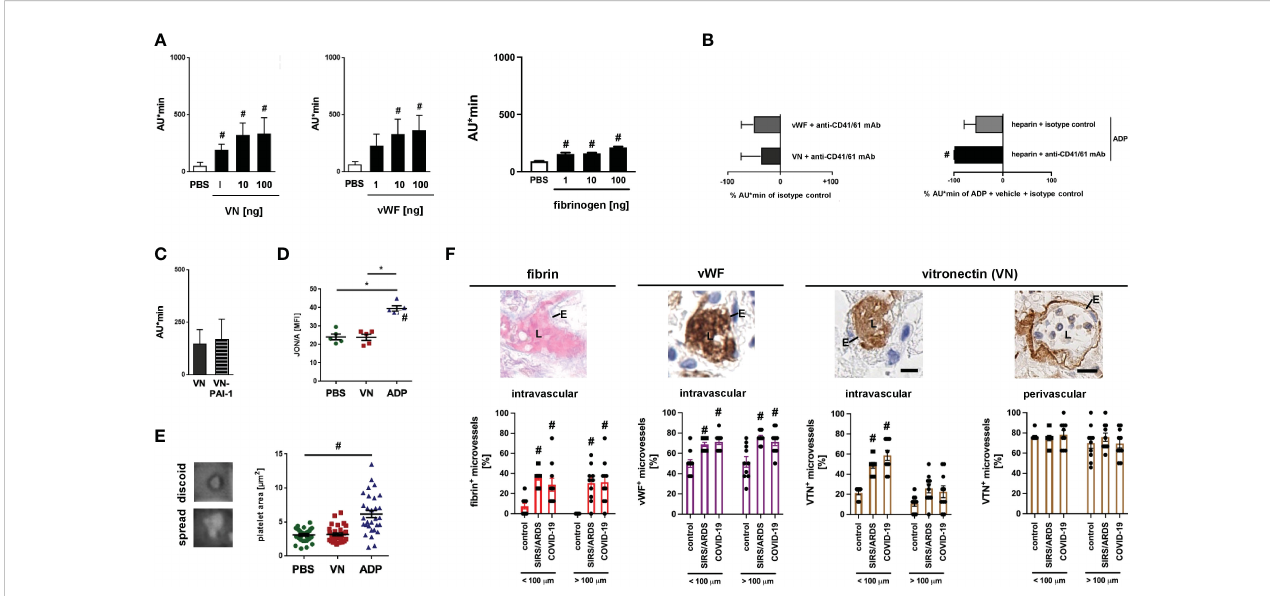
FIGURE 4 VN promotes platelet aggregation via CD41/61. (A) Aggregation of primary platelets from the peripheral blood of WT mice upon addition of different doses of recombinant mouse VN, vWF, or fi brinogen as assessed in vitro by rotational thrombelastometry, quantitative data are shown. Experiments were repeated upon addition of (B) isotype control antibodies or blocking monoclonal antibodies directed against CD41/CD61, upon stimulation with ADP after treatment with heparin and isotype control antibodies or blocking monoclonal antibodies directed against CD41/CD61, or (C) upon addition of VN- PAI-1 (mean ± SEM for n=4-6 per group; #p<0.05 vs. PBS). (D) Recognition of activated integrin CD41/CD61 by antibody JON/A on primary platelets from the peripheral blood of WT mice upon addition of PBS, VN, or ADP as assessed in vitro by fl ow cytometry (mean ± SEM for n=5 per group; #p<0.05 vs. PBS or VN). (E) Spreading on glass slides of primary platelets from the peripheral blood of WT mice upon addition of PBS, VN, or ADP as assessed in vitro by light microscopy, representative images and quantitative data are shown (mean ± SEM for n=22-30 per group; #p<0.05 vs. PBS). (F) Deposition of fi brin (bright red; upper left image), vWF (brown; upper left/middle image), and VN (brown; upper and right images) in the pulmonary microvasculature of patients with severe systemic infectious in fl ammation (COVID-19), severe systemic non-infectious in fl ammation (pancreatitis-associated SIRS/ARDS), and control patients as assessed by LADEWIG ’ s staining and immunohistochemistry (scale bars: 25 μm; L=lumen; E=endothelium). Representative images and quantitative data for pulmonary microvessels exhibiting inner diameters of more or less/equal than 100 μm are shown (mean ± SEM for n=10